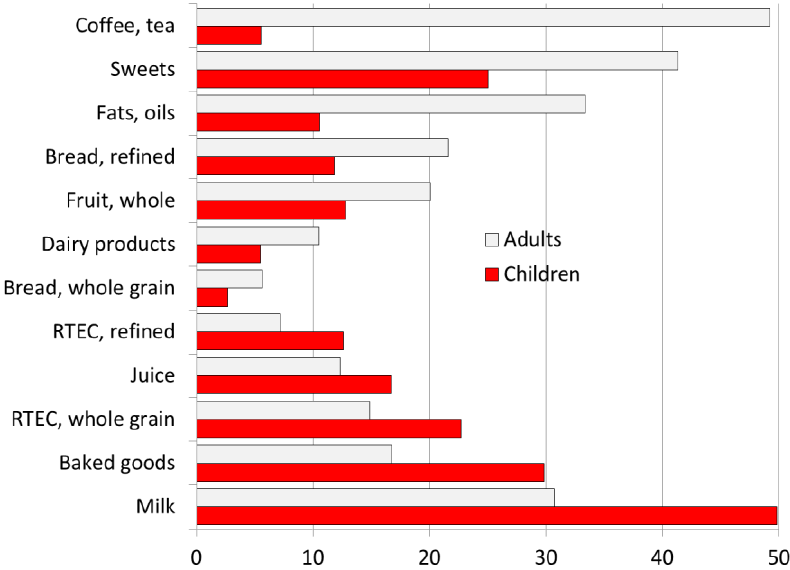
Figure 6. Percent consumers of specific food groups at breakfast by age group (data for breakfast consumers only). RTEC stands for Ready to eat cereals.